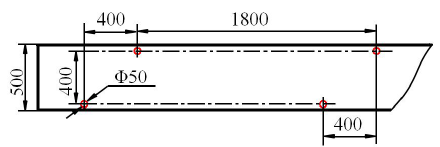
Figure 9: The slender structural part